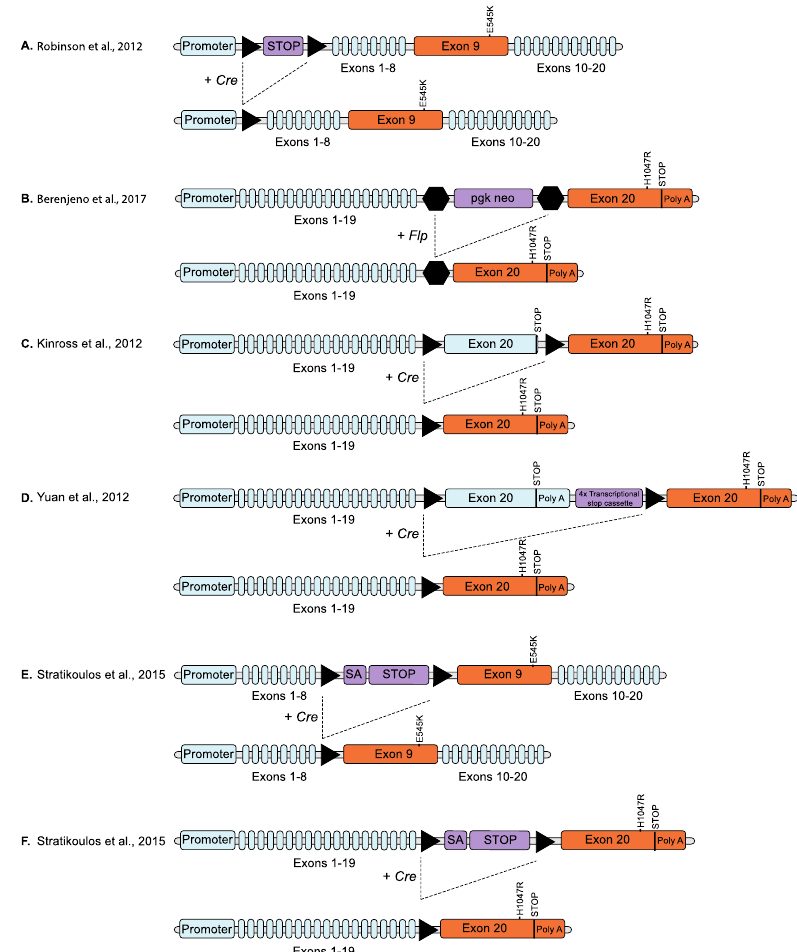
Figure 3. Schematic overviews of conditional knock-in PIK3CA mutation models. Triangles represent loxP sites. ( A ) Homologous recombination was used to insert a loxP -flanked transcriptional stop cassette (STOP) immediately upstream of the exon containing the initiation codon and replace exon 9 with an exon containing a E545K mutation, in one allele of the endogenous Pik3ca gene. Expression of the mutant allele is prevented by the stop cassette until removed by the expression of Cre recombinase (Cre) [63]. ( B ) A neomycin selection cassette (pgk neo) flanked by frt sites was inserted in the intron between exons 19 and 20 and point mutations resulting in a H1047R mutation introduced into exon 20, of one allele of the endogenous Pik3ca gene. The presence of the neo cassette suppresses the expression of the targeted allele until removed by Flp recombinase [65]. ( C ) LoxP sites were inserted on either side of the endogenous wild type exon 20 and a copy of exon 20 coding for a H1047R mutation inserted downstream of the endogenous stop codon (and after the downstream LoxP site) in one allele of the endogenous Pik3ca gene. The modified allele continues to express wild type protein (with expression of the inserted mutant exon prevented by the stop codon in the endogenous exon 20) until the expression of Cre recombinase which removes the wild type exon 20, replacing it with the mutated exon 20 [46]. ( D ) Similar to (C) but includes a transcriptional stop cassette downstream of the endogenous gene and before the inserted mutant exon [65]. ( E ) Point mutations coding for a E545K mutation were introduced into exon 9 of one allele of the endogenous Pik3ca gene and a loxP -flanked splice acceptor site (SA) and transcriptional stop cassette inserted into the intron immediately upstream of the mutated exon. Expression of the mutated exon is prevented by the stop cassette until removed by Cre recombinase [67]. ( F ) Similar to (E) but targeting exon 20 (H1047R) [68]. Triangles represent loxP sites and hexagons represent frt sites. Blue colour indicates endogenous gene sequence, orange indicates modified Pik3ca exon and purple indicates vector DNA